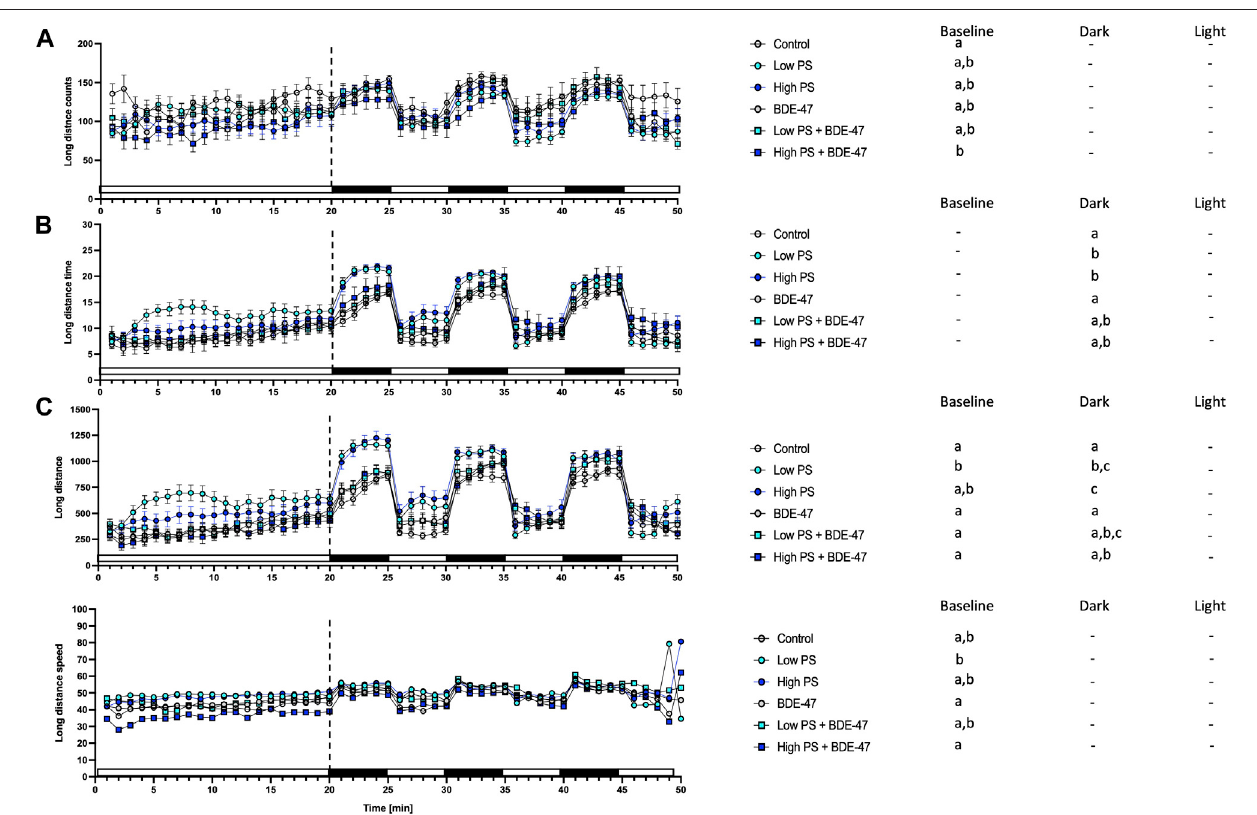
FIGURE8| Longmovementparameters from7 dpfzebra fi shlarvaelocomotion assays( n =3)withatotal n =48foreach treatment groupconsistingofexposures to vehicle control, 2.5 ppm PS, 25 ppm PS, 10 ppt BDE-47 or their combinations. All measurements over the 50 min assays were binned in 1 min units, with 20 min baseline followed by 3 cycles of 5 min dark light alterations. Average long counts of movement events +/ − S.E.M. (A) , average duration of total movement events +/ − S.E.M in s (B) , Distance of long movement events +/ − S.E.M in mm (C) , Average speed +/ − S.E.M of long movements in mm/s (D) . Data were analyzed using separate one-way repeated measurement ANOVAs for baseline, dark, and light conditions. Different letters indicate signi fi cant differences between groups as analyzed by Tukey ’ s post-hoc test ( p < 0.05).